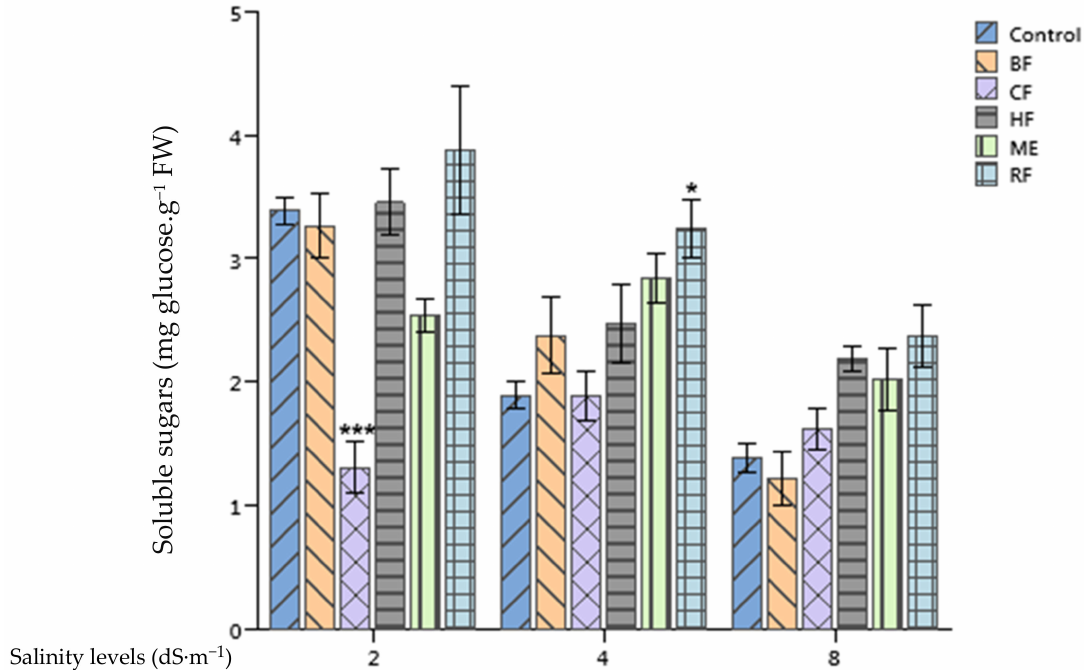
Figure 3. Effect of priming tomato seeds with Ulva lactuca methanol extract (ME), hexane fraction (HF), chloroform fraction (CF), n-butanol fraction (BF), and residual fraction (RF) under different salinity levels (2, 4, 8 dS · m − 1 ) on soluble sugars content of tomato leaves. Mean ± SD values followed by asterisks indicate significant differences between treatments and the control (* p < 0.05; *** p <